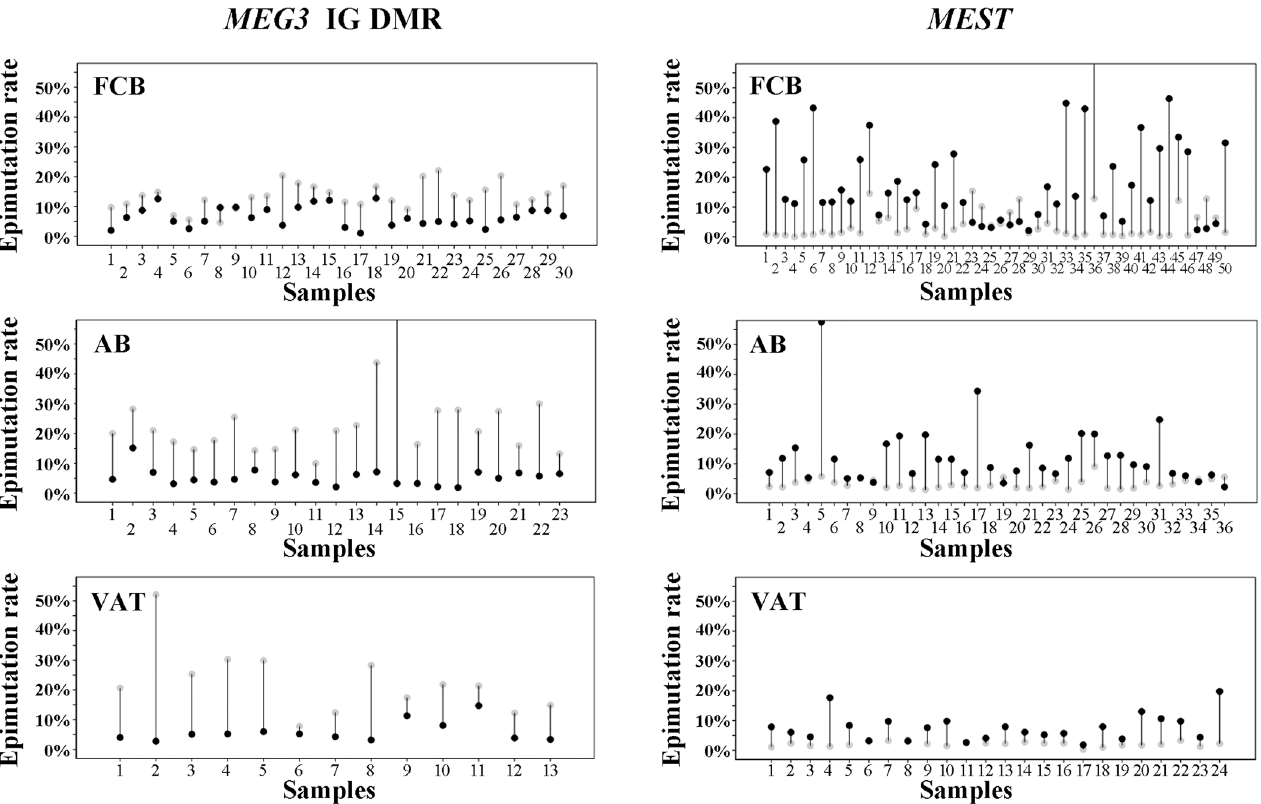
Fig 3. Epimutation rates of the MEG3 IG DMR and the MEST promoter in individual samples. The percentage of paternal(black dots) versus maternalalleles(gray dots) with > 50% aberrantly(de)methylated CpGs was determinedby DBS with the Roche GSJunior in individualFCB, AB, and VAT samples.With very few exceptions, the unmethylated allelesof the paternallyimprinted MEG3 and the maternally imprinted MEST genes displayedmuch higherepimutationrates than the methylated